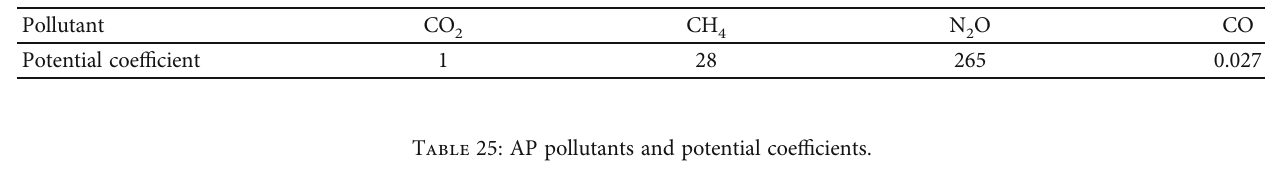
Table 24: GWP pollutant and potential coe ffi cient.